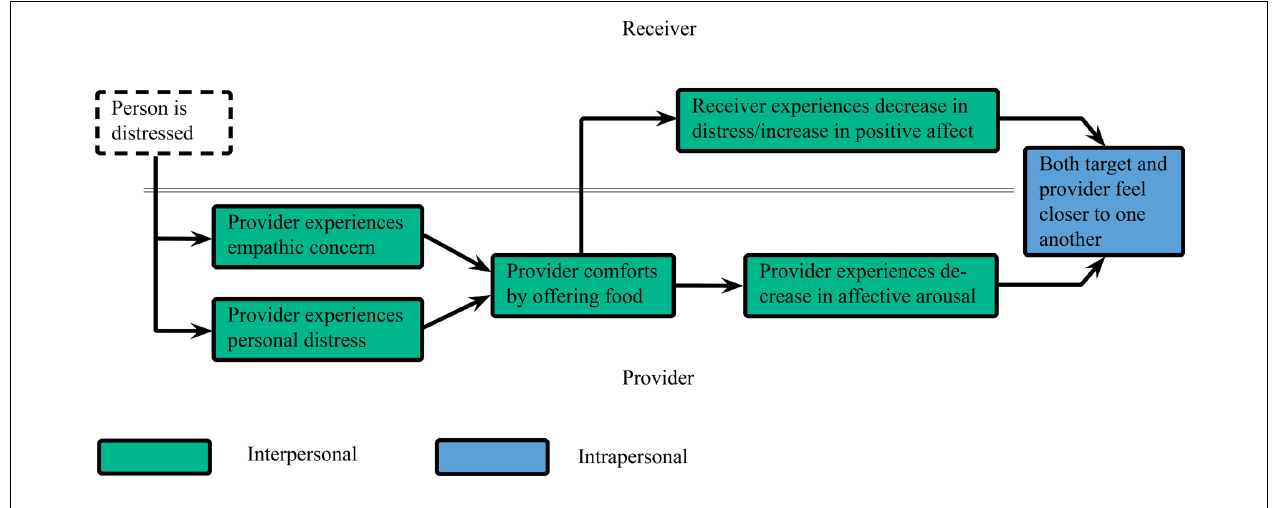
FIGURE 1 | Example of empathic emotion regulation by food